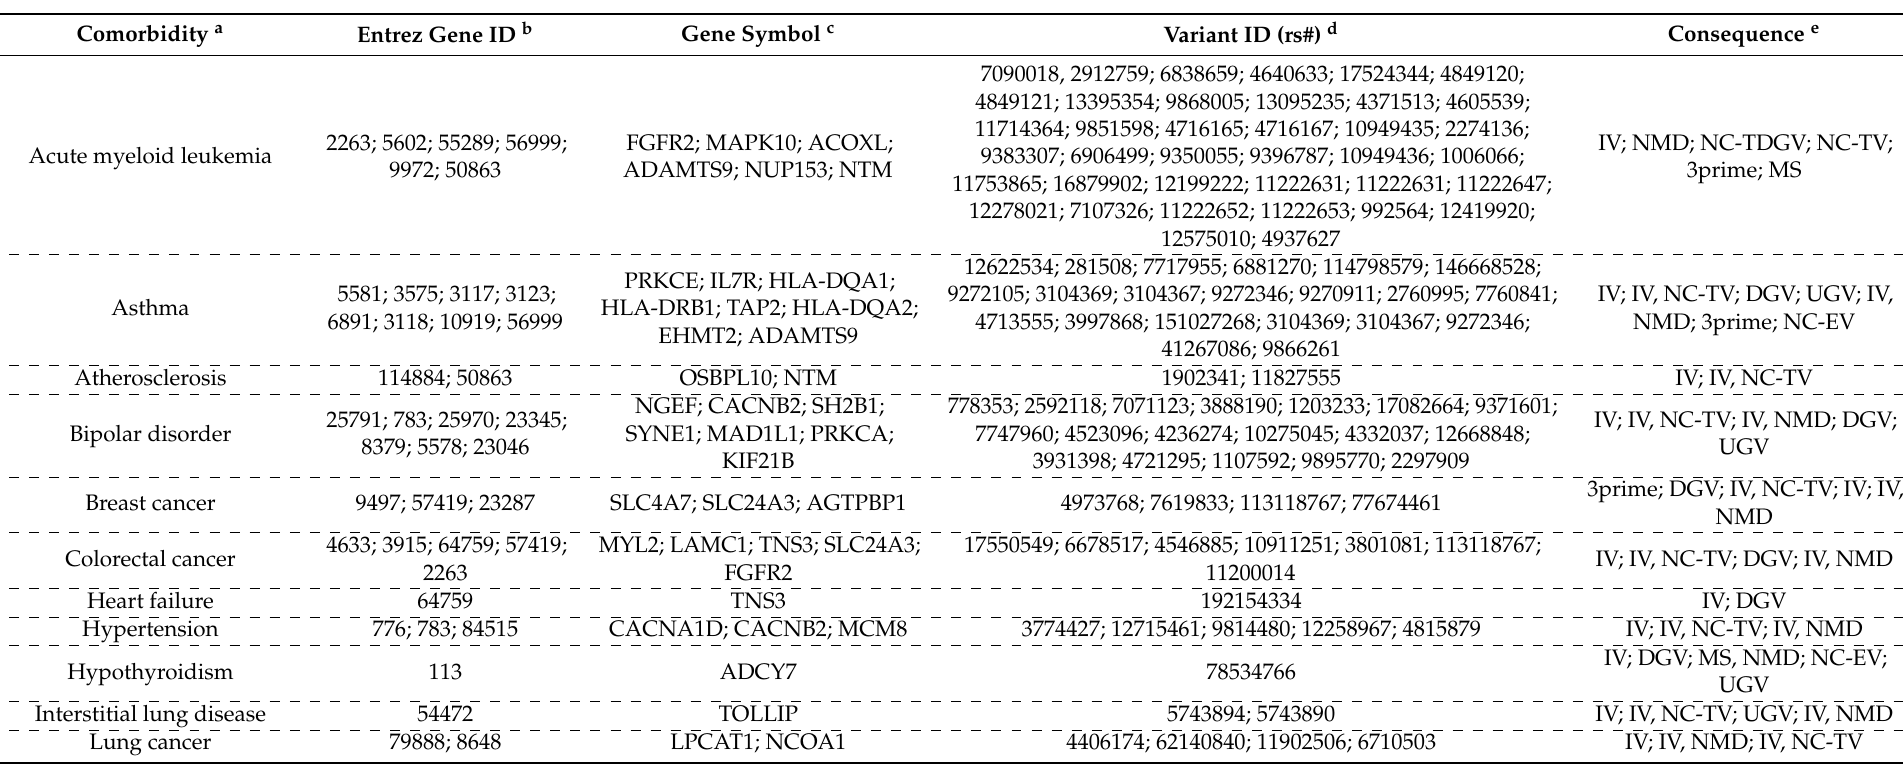
Table 3. VEP genes and SNPs matched to significant MAGMAv1.07b COVID-19 comorbidity-associated genes. Total of 54 gene IDs from STRINGv11.0 analysis (50 genes after synonyms processed) were matched with significant genes from 22 comorbidities with significant pathways identified by MAGMAv1.07b. a Variant effect predictor (VEP) analysis of